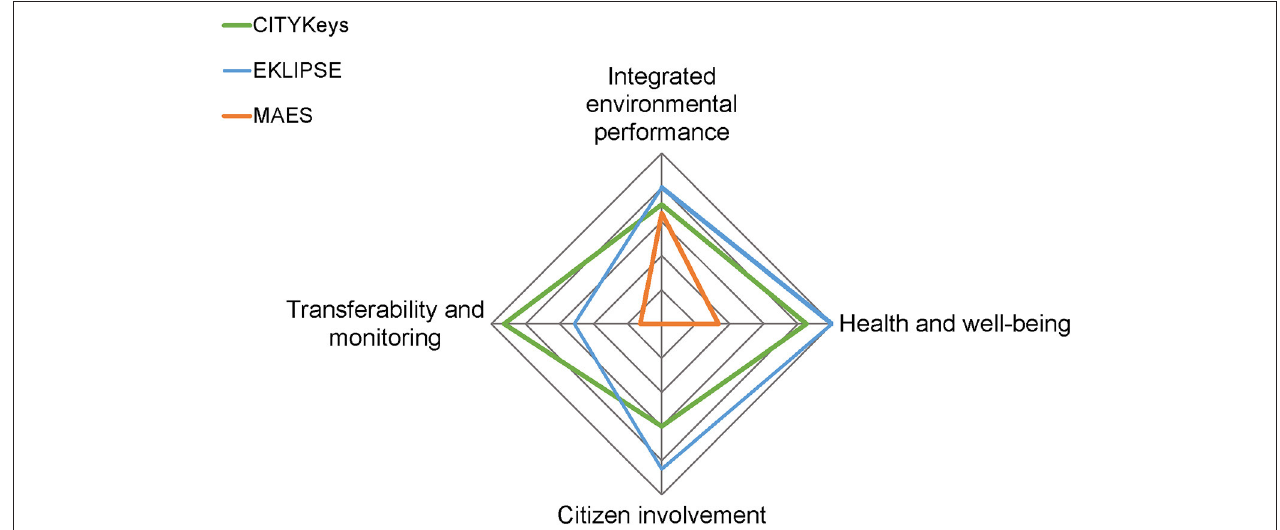
FIGURE 2 | Conceptual mapping of the MAES (Maes et al., 2016), EKLIPSE (Raymond et al., 2017), and CITYkeys (Bosch et al., 2017) frameworks, respectively, against recommended indicators per Kabisch et al. (2016) for evaluating the effectiveness of NBS for climate change adaptation and mitigation, and associated co-benefits.